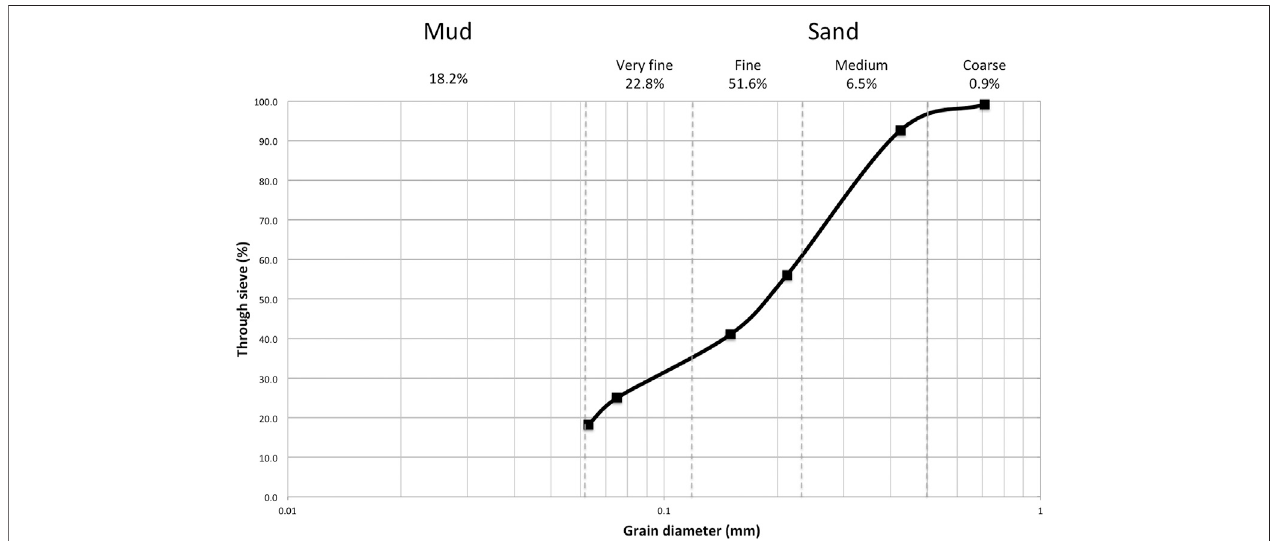
FIGURE 5 | Grainsize of the siliciclastic component of the samples: sand-size grains account for a total 81.8% while mud reached 18.2%. The siliciclastic component account for 46% of the total sample, while the total carbonate fraction (cement and few clasts) dissolved with acetic acid solution was 54% of the total